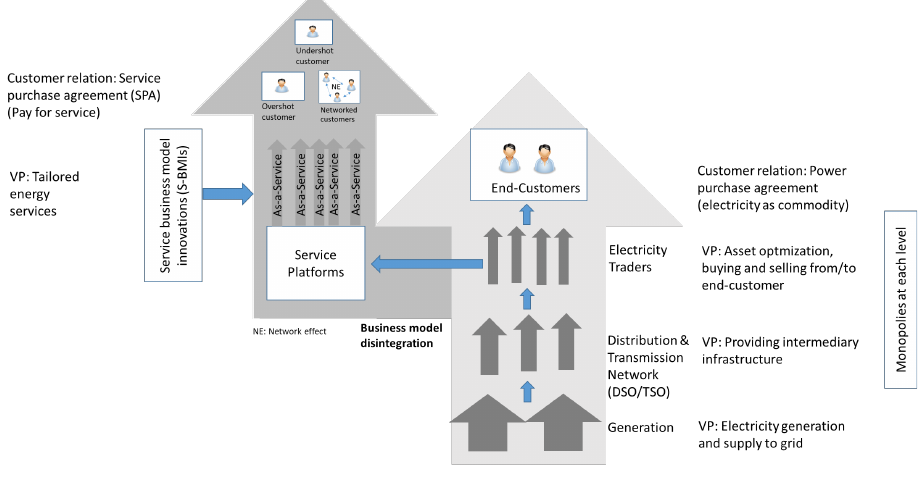
Figure 1. Disintegration of the value chain, (VP = Value proposition, NE = Network